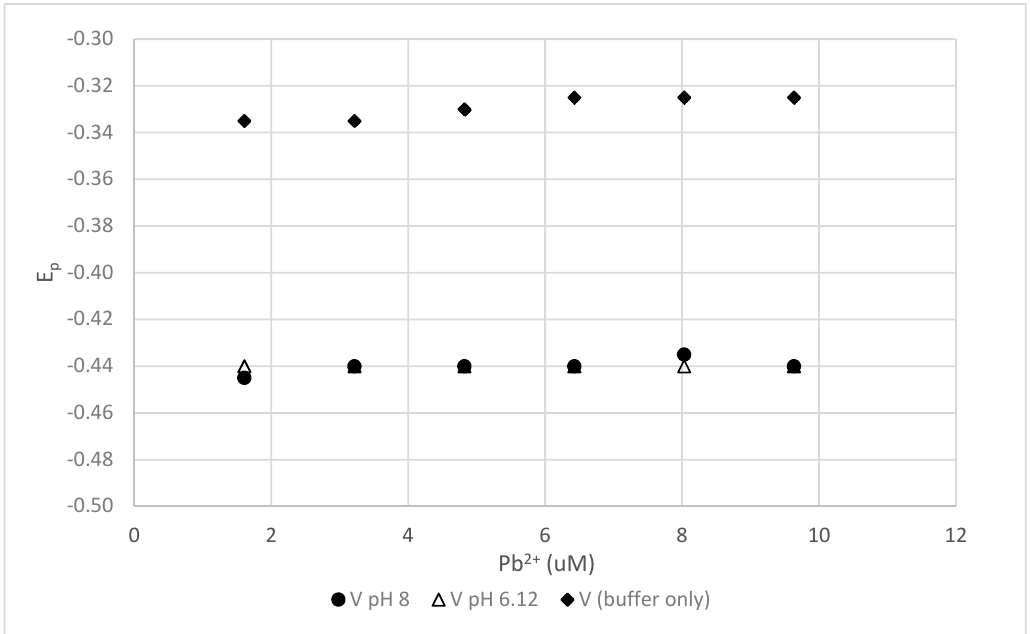
Figure 3. DPP results for Pb 2+ in the presence of 100-mg/L polyacrylate. There is little difference in the results for pH 6.12 and pH 8.